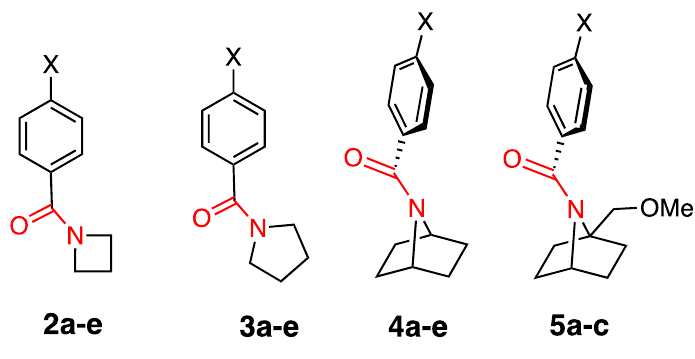
Figure 6. Model molecules used in this study. N -Benzoylazetidines (2a – e) and N -benzoylpyrrolidines (3a – e) were examined as monocyclic amides. N -Benzoyl-7-azabicyclo[2.2.1]heptanes ( 4a – e ) and